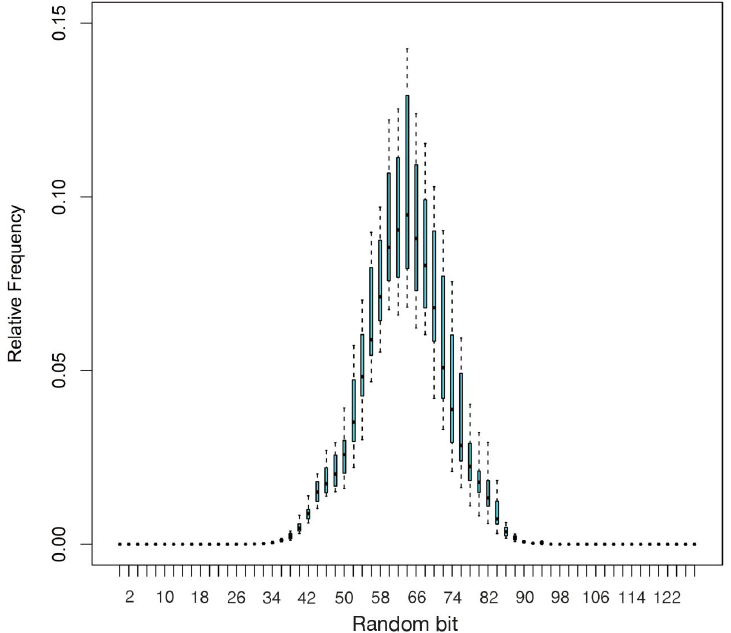
Figure 7. Hamming distance